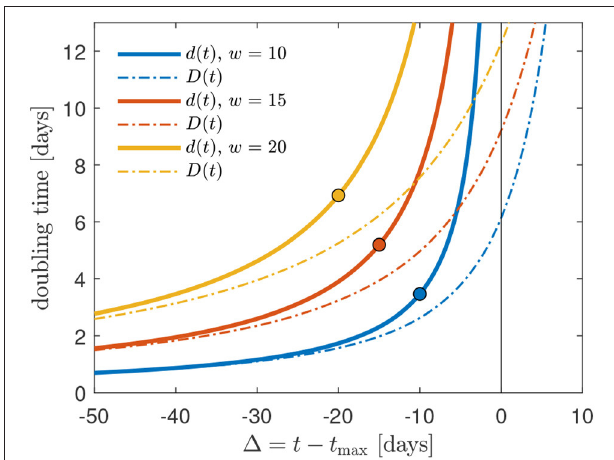
FIGURE 2 | Comparison of the daily instantaneous ( d ) and cumulative ( D ) doubling times as a function of the time 1 relative to the peak time for three values of the Gaussian width w 10,15,20. The circles mark 1 0 for c max = cf. Equation (5): the GM should not be used at times smaller than 1 0 .